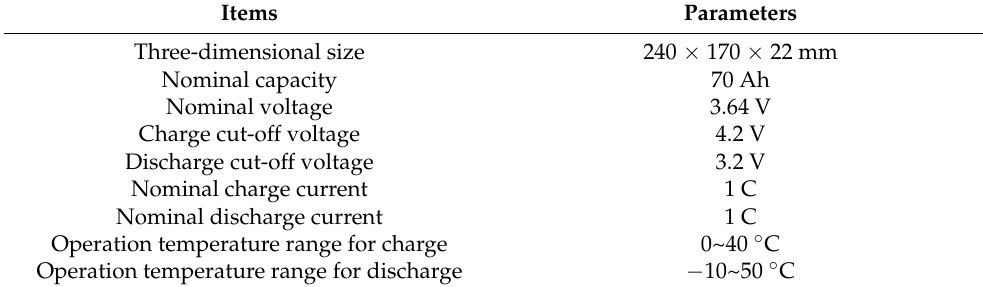
Table 1. Primary design and performance parameters of the test object.